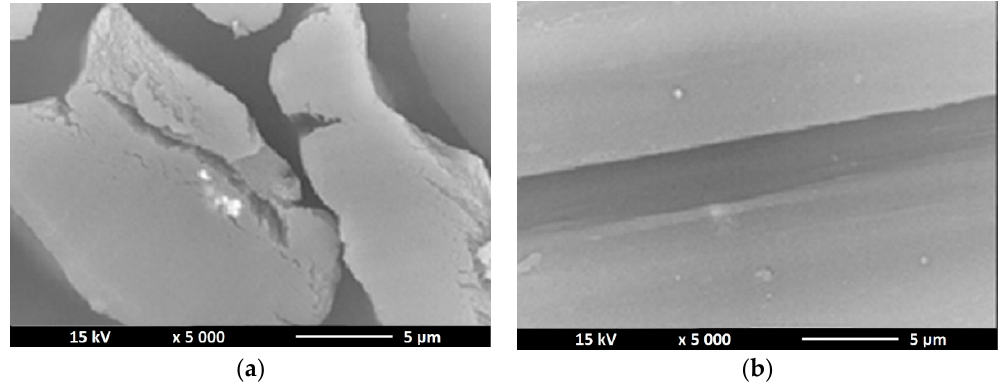
Figure 6. SEM images of cross section ( a ) and surface ( b ) of alginate fibers with 2% ZnO nano additive.